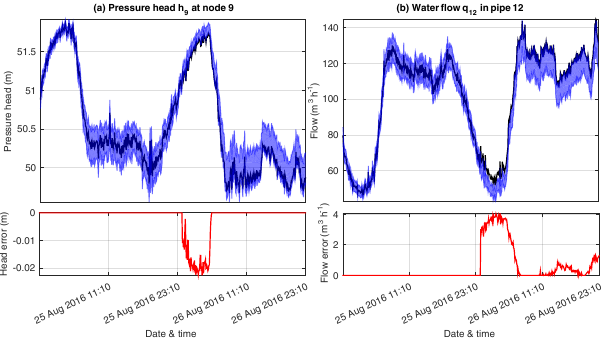
Figure 5. The effect of a leakage occurring in the network at time “26 August 2016 00:10” on a pressure (a) and a flow (b) state, com- pared to the estimated uncertainty bounds for the same states calcu- lated by the IHISE algorithm. Below each graph, the corresponding error of the state compared to the calculated bounds is